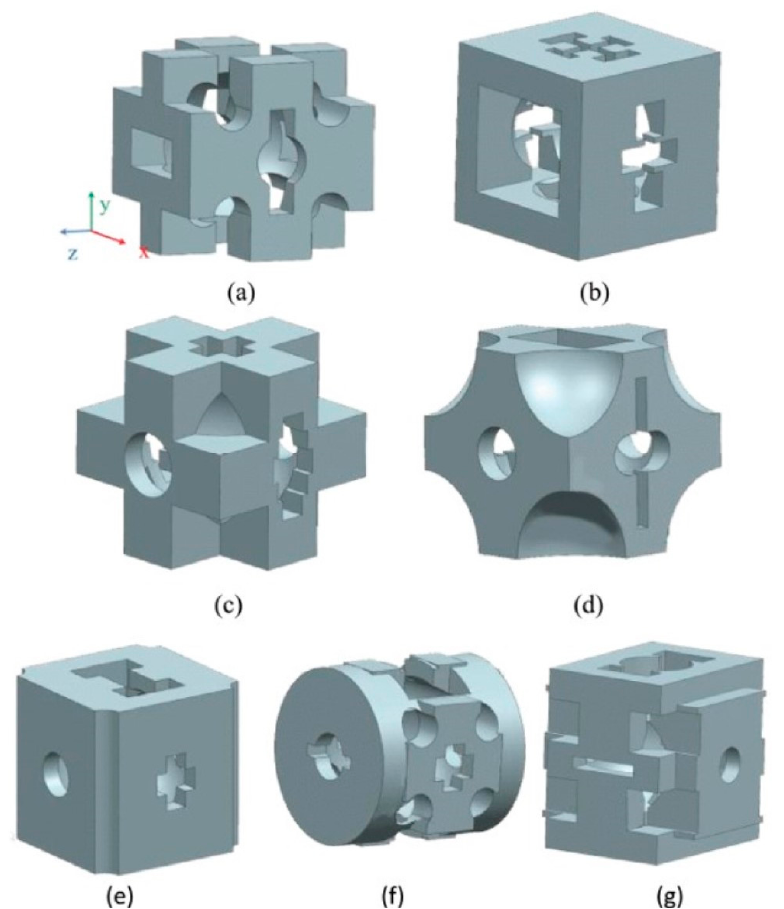
Figure 1. Cell model after optimization at different positions: ( a ) M15; ( b ) M16; ( c ) M17; ( d ) M18; ( e ) M19; ( f ) M20; and ( g ) M21 (numbers represent different positions) (Adapted with permission from Liu et al., 2021).[24].